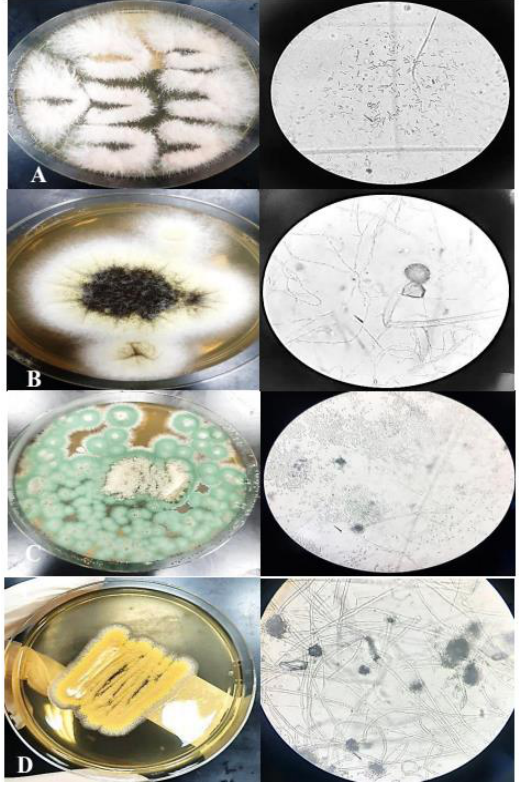
Figure 3. Different fungal strains on SDA and scotch tape mount: ( A) Fusarium ( B) Aspergillus niger ( C) Aspergillus fumigatus ( D) Aspergillus flavus